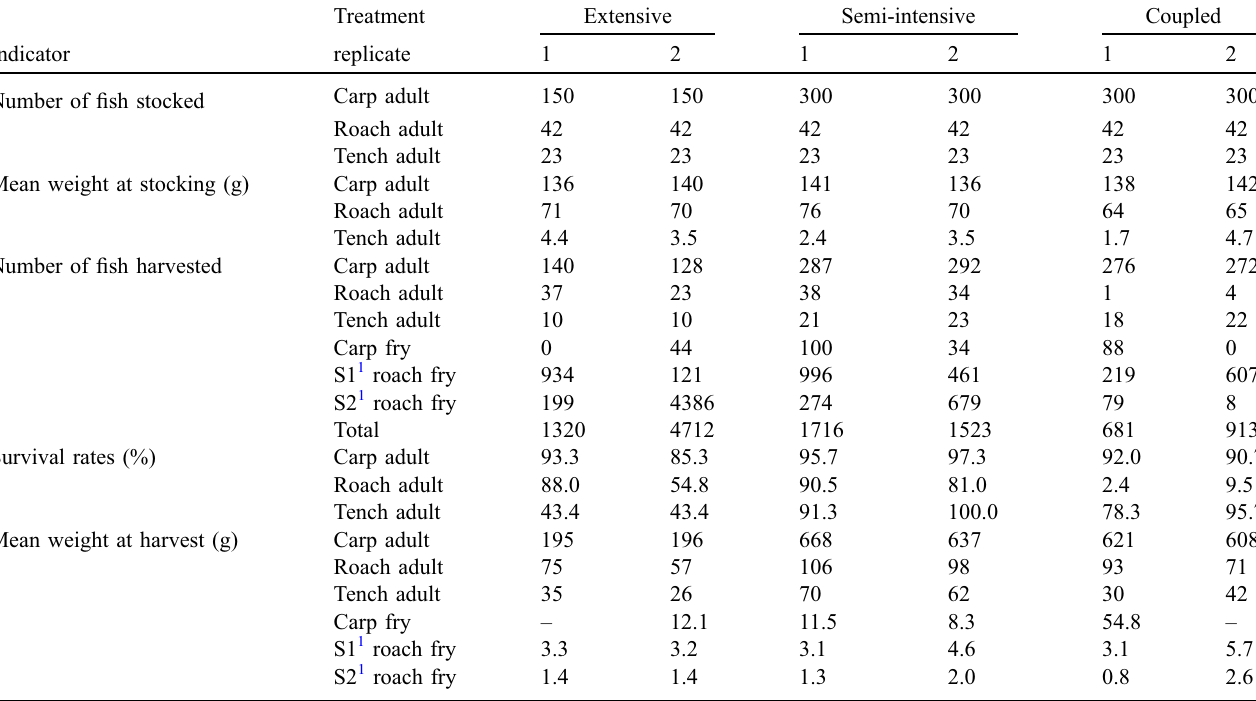
Table 2. Harvest and survival rate results. Treatment